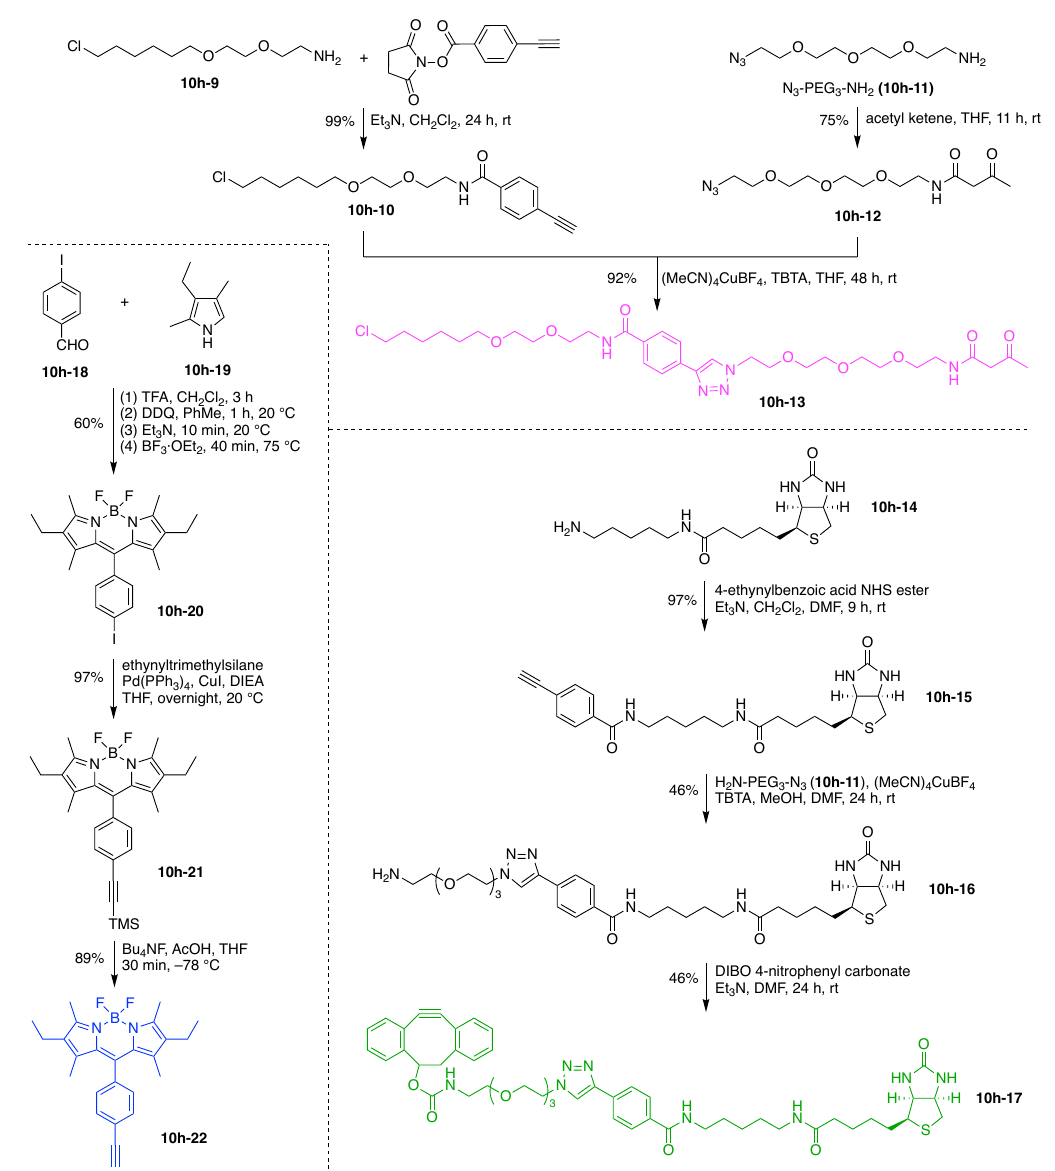
Figure 46. Synthesis of three appendages for the triazido hub. With all segments ready, the tri-azide hub 10h-8 was treated with labeling unit pre- cursor 10h-13 to give mono-triazole 10h-23 , then with fluorophore unit precursor 10h-22 with the reagent Cp*Ru(PPh 3 )Cl 2 (where Cp* is pentamethylcyclopentadienyl) to give di- triazole 10h-24 (wherein the triazole contains 1,5-disubstitution rather than the typical 1,4- disubstitution) and then with biotin tag precursor 10h-17 to give tri-triazole 10h (Figure 47). The three couplings are restricted in sequence and must be carried out on the basis of